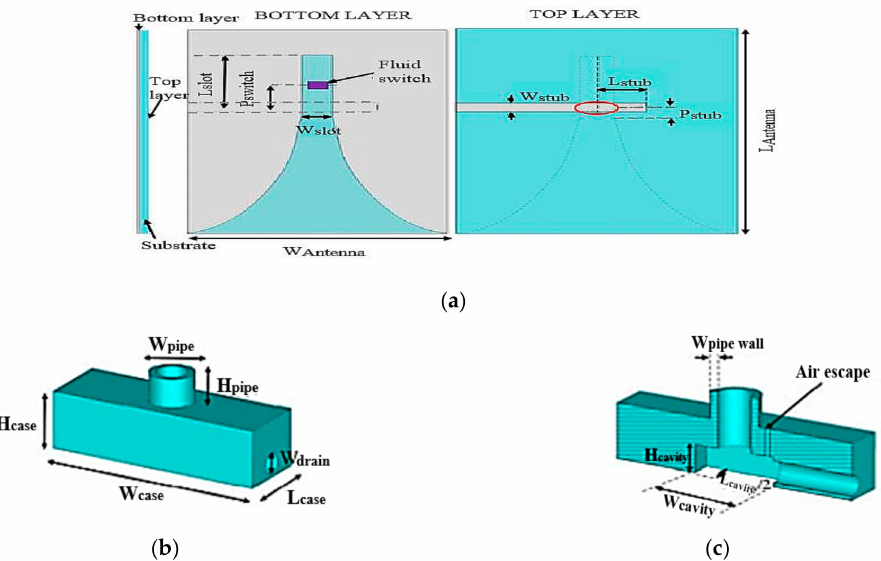
Figure 32. ( a ) Bottom and top layer of the fluidically switched antenna. ( b ) Fluid switch. ( c ) Cross sectional view of the fluid switch